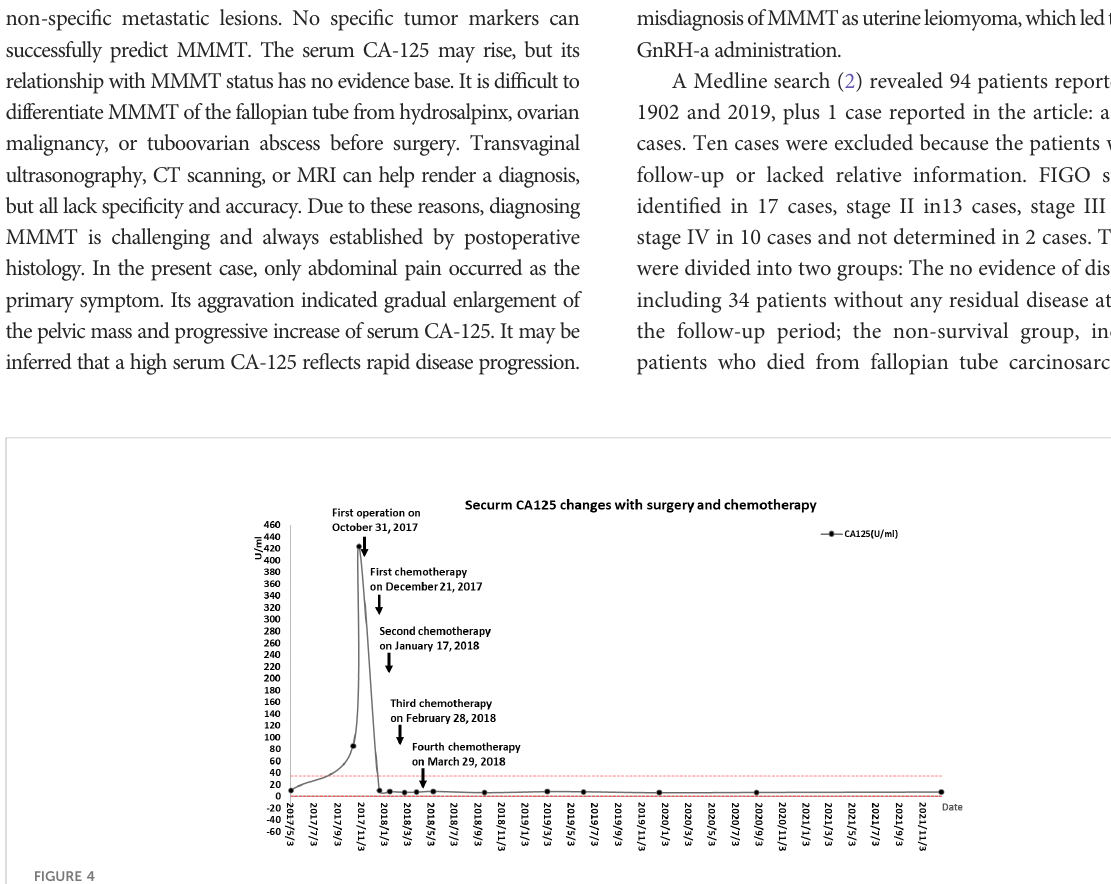
FIGURE 4 Changes in serum tumor